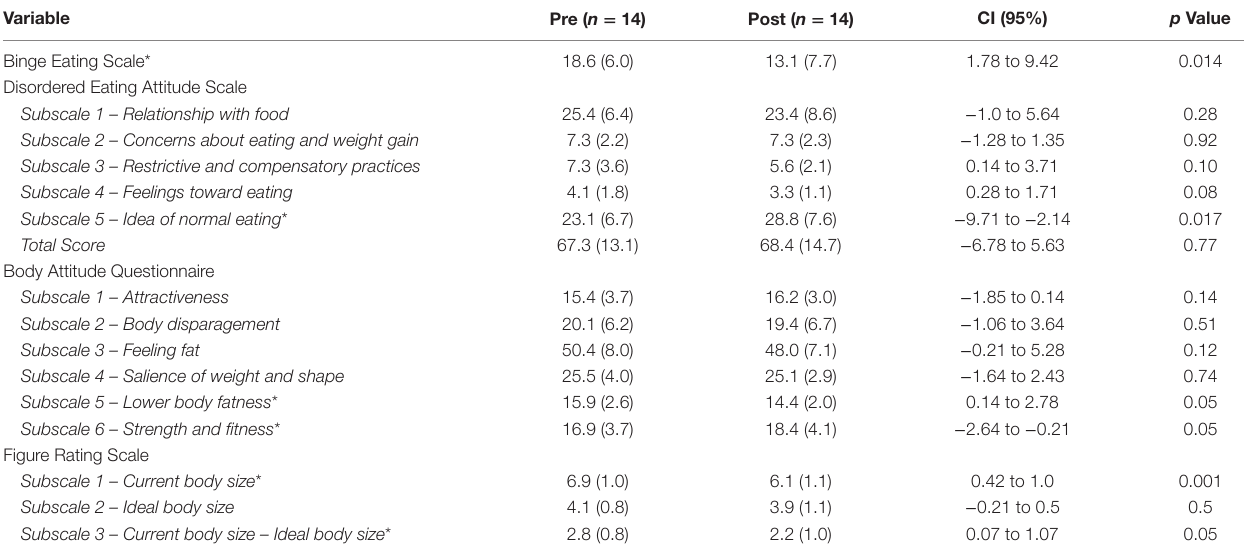
TaBle 3 | Psychological and behavioral assessments before and after the intervention. Variable